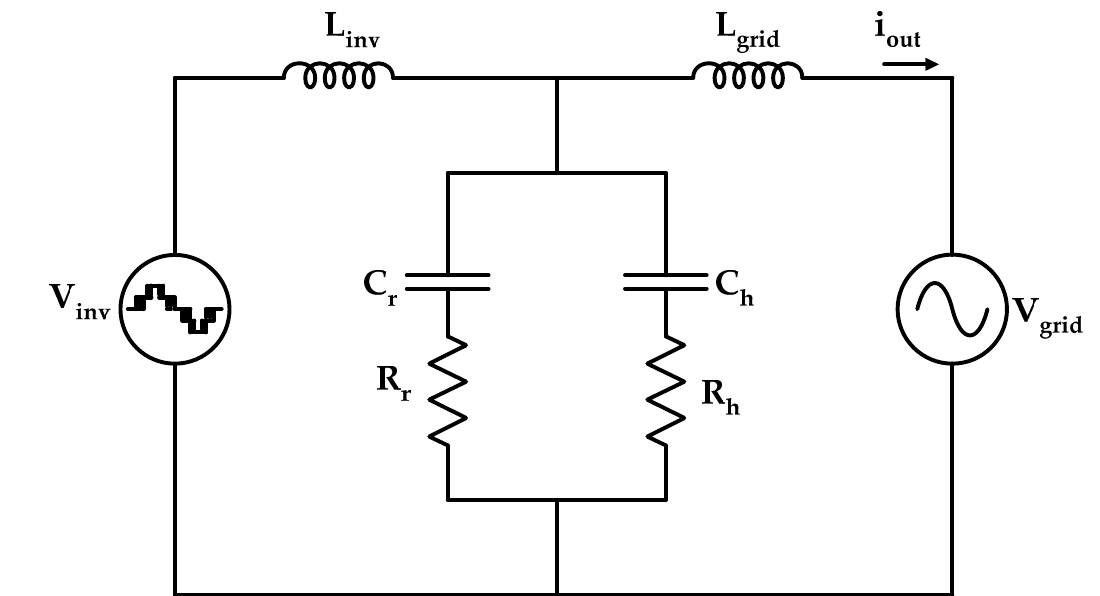
Figure 2. Proposed filter structure for the five-level inverter.